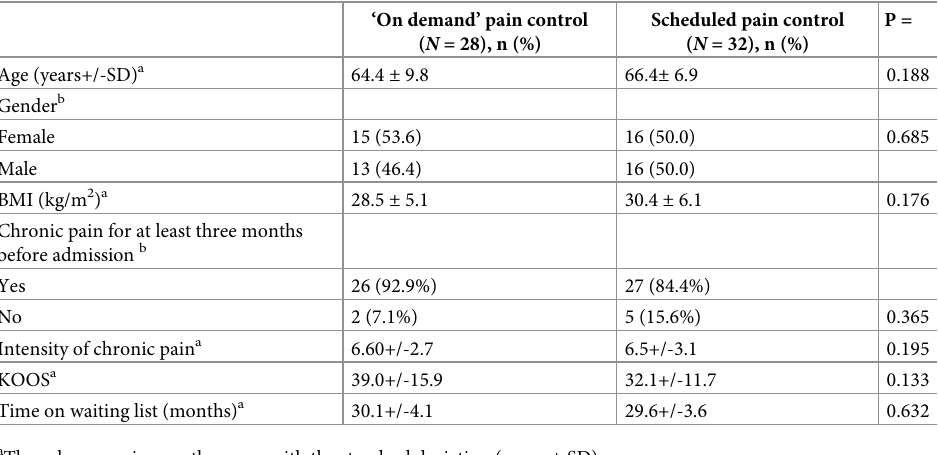
Table 1. Patient demographics and pre-operative characteristics.